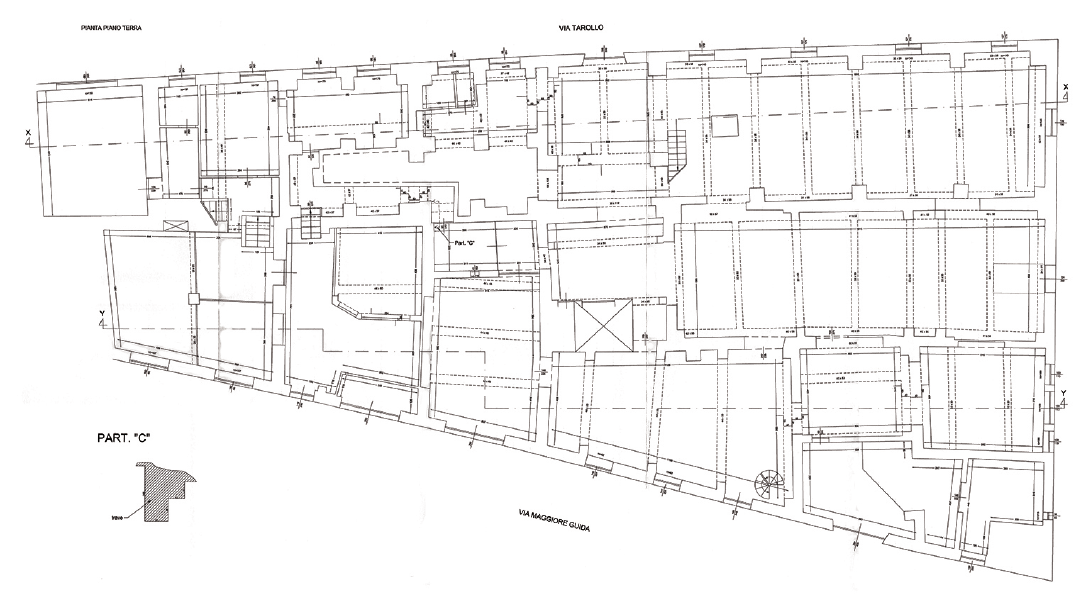
Figure 6. Geometric survey of the first floor.